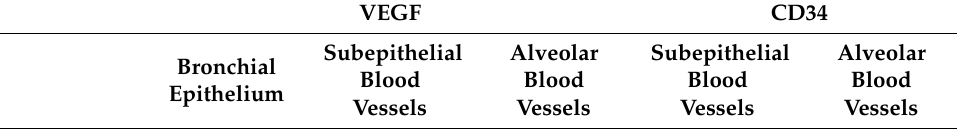
Table 2. Appearance and relative number of VEGF-containing and CD34-containing cells in 19 rela- tively healthy lung tissue specimens. Figure 5. ( a ) Occasional VEGF-positive cells (arrows) are seen in non-changed bronchial epithelium of a 29-year-old male. VEGF IMH, X200. ( b ) Moderate number of VEGF-positive alveolar blood vessels and alveolar epithelial cells in 29-year-old male with metaplastic bronchial epithelium, VEGF IMH, X200.